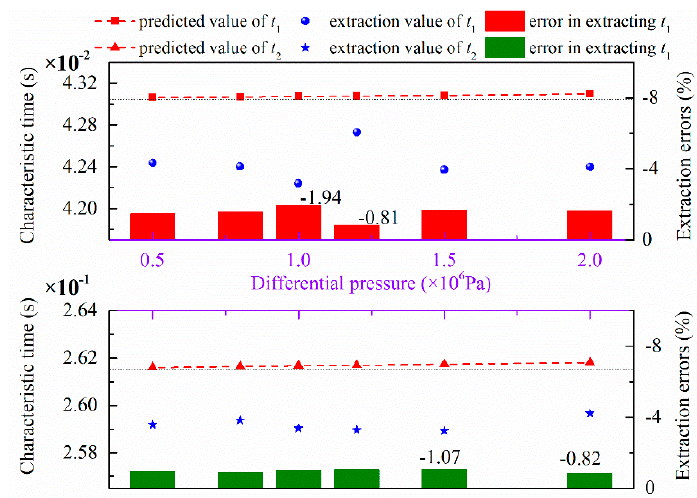
Figure 15. Predicted values, extraction values, and extraction errors of t 1 and t 2 for different differential pressures.